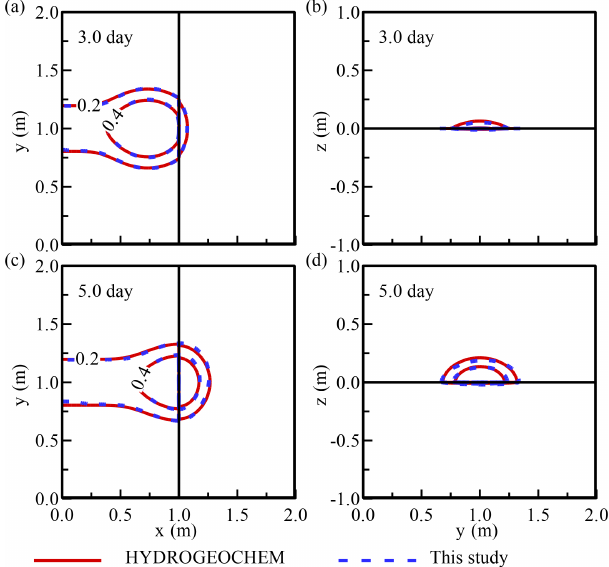
Figure 7. Comparison of the concentration distributions for the developed DFN model and the HYDROGEOCHEM model for a cross-shaped fracture network: (a) top view of the horizontal fracture at t = 3 . 0 day, (b) front view of the vertical fracture at t = 3 . 0 day, (c) top view of the horizontal fracture at t = 5 . 0 day, and (d) front view of the vertical fracture at t = 5 . 0 day.